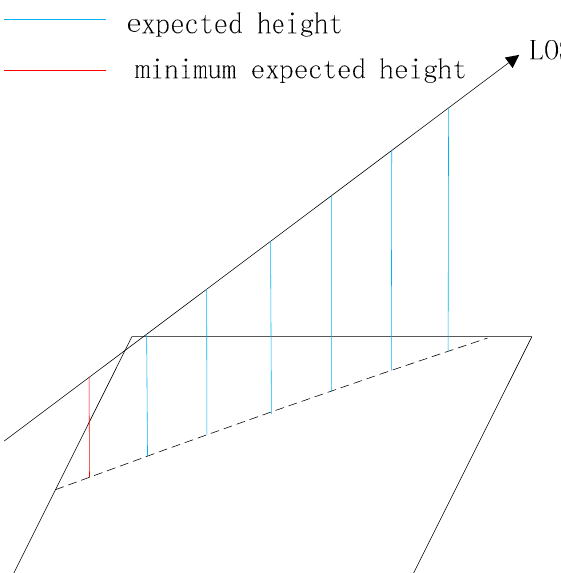
Figure 9. Expected height and minimum expected height in an area bounded by the parallelogram.